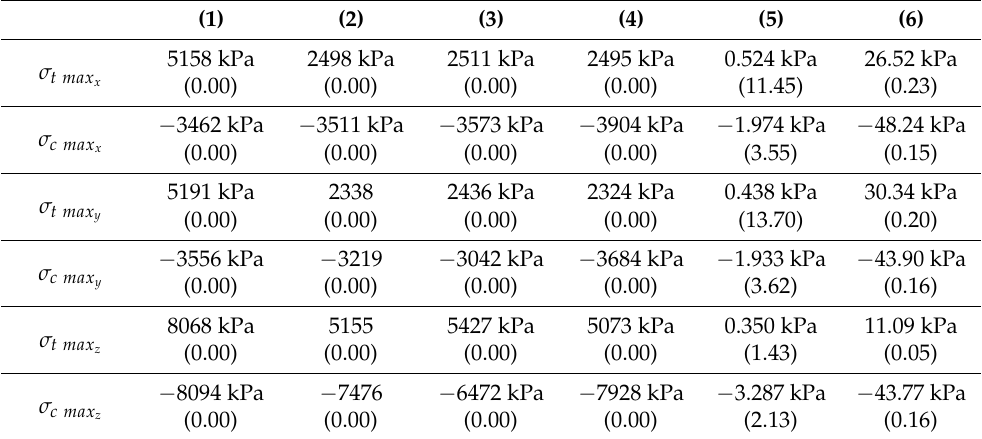
Table 4. Maximum tensile and compression stresses σ t , c max The safety factor S is written in brackets.